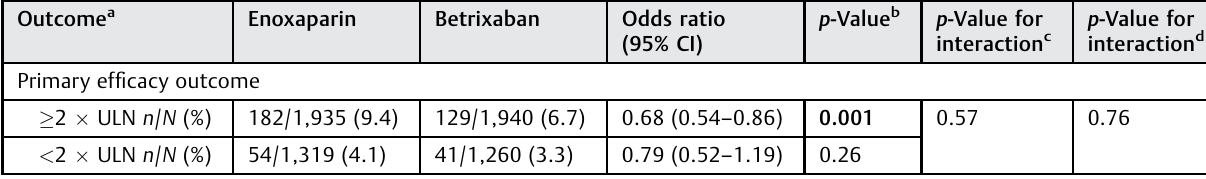
Table 4 Interaction for D-dimer category or D-dimer concentration and treatment effect through end of study Outcome